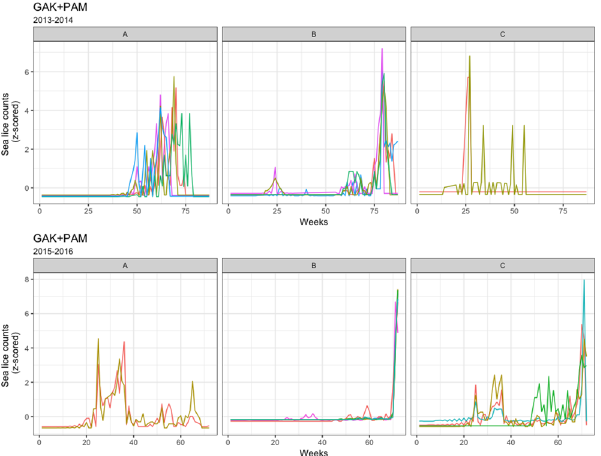
Fig 6. Farm III clustering per production cycle. Time series plots for the most stable clustering algorithm for Farm III, one from each production cycle.